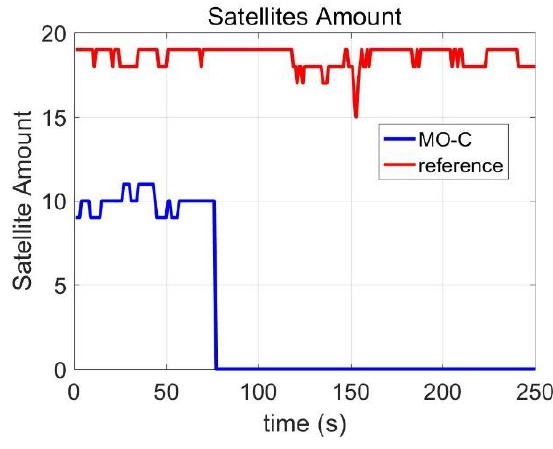
Figure 16. Satellites amount.